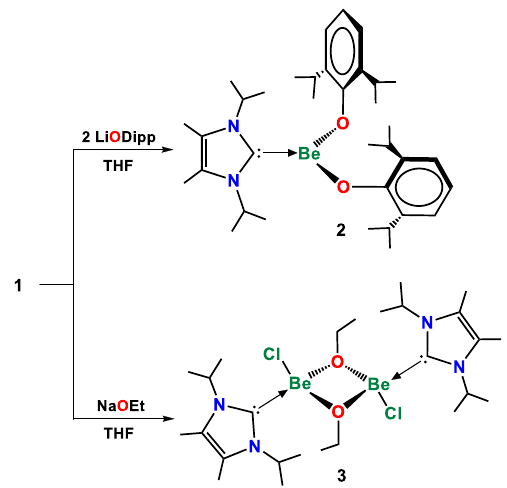
Scheme 2. Synthesis of (sIPr)Be(ODipp) 2 and [(sIPr)BeCl(EtO)] 2 .